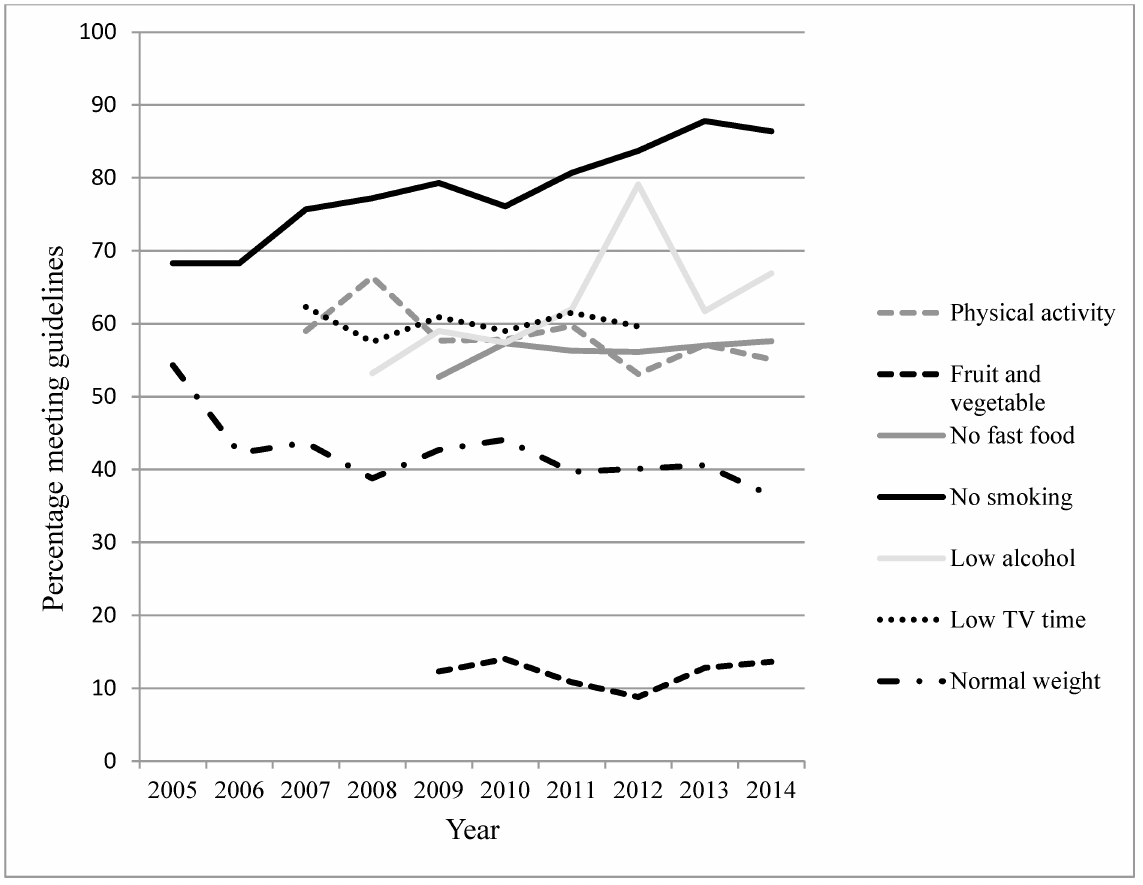
Fig 1. Trends in healthy lifestyle factors in